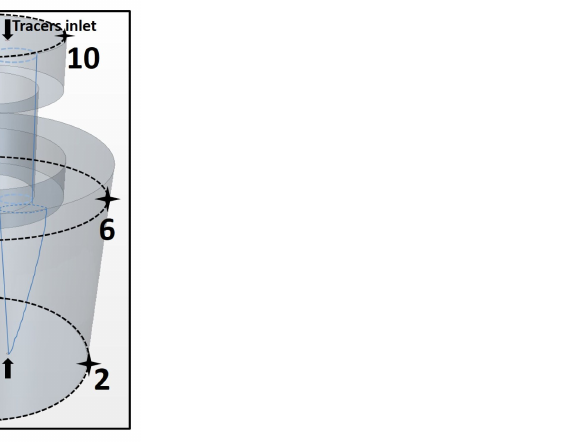
Figure 4. Schematic diagram of location of 12 monitor points (marked by numbers), gas inlet and tracer